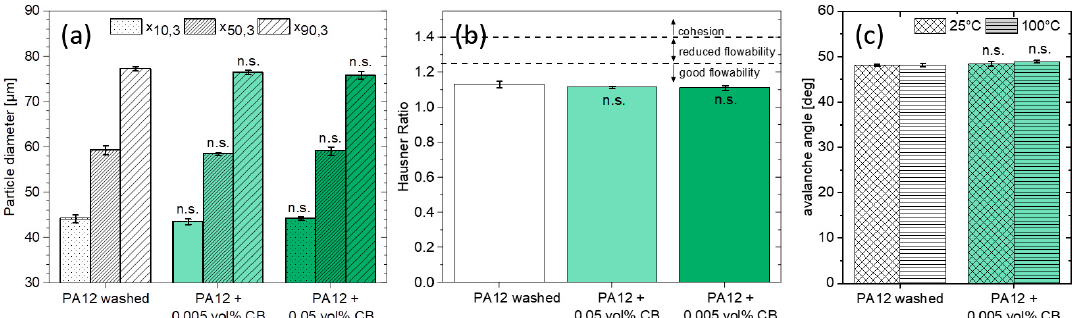
Figure 8. ( a ) Polymer microparticle size distribution, ( b ) Hausner ratio, and ( c ) avalanche angle before and after colloidal additivation for 3 samples each. Particle sizes are based on the projected area of a sphere x area . The significance analysis shows no significant differences (n.s.) through the addition of different amounts of CB.